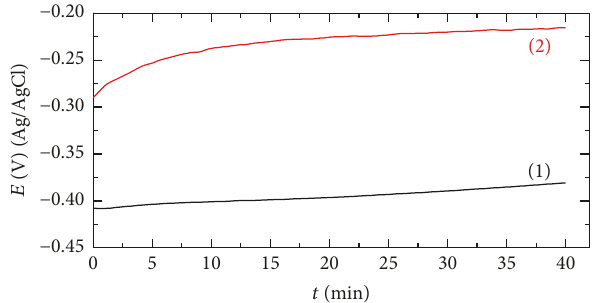
Figure 2: Change of the open-circuit potential with time for ( 1 ) Fe- 36% Ni and ( 2 ) Fe-45% Ni alloys in 1M HCl